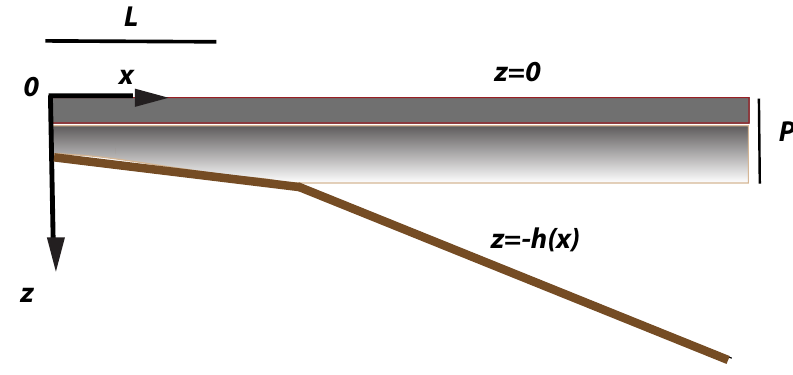
Figure 5. Schematic cross-section of the model domain. A light, thin oil slick sits atop the ocean. The ocean’s mixed layer of thickness P is laden with oil droplets, accounted for as a concentration. The distance from the shore, at x = 0 , is denoted by x . The break zone extends to x = L . The ocean surface is at z = 0 and bottom topography is fixed and described by z = − h ( x )